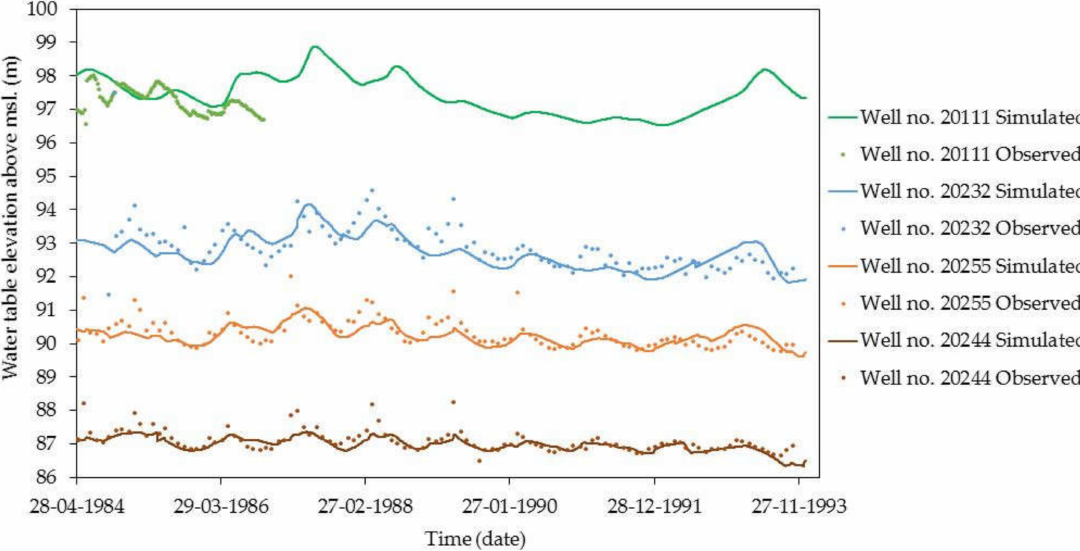
Figure 7. Comparison of water table fluctuations in observation wells (observed) and those simulated using MODFLOW with the HYDRUS-1D package (simulated).